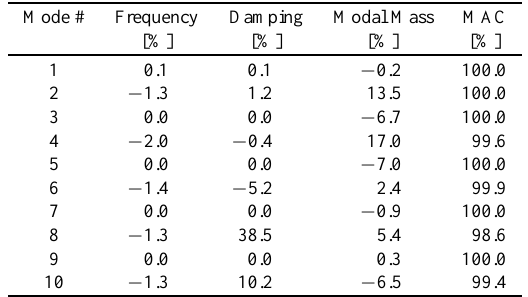
Table 1 Deviations of identified modal parameters with new method